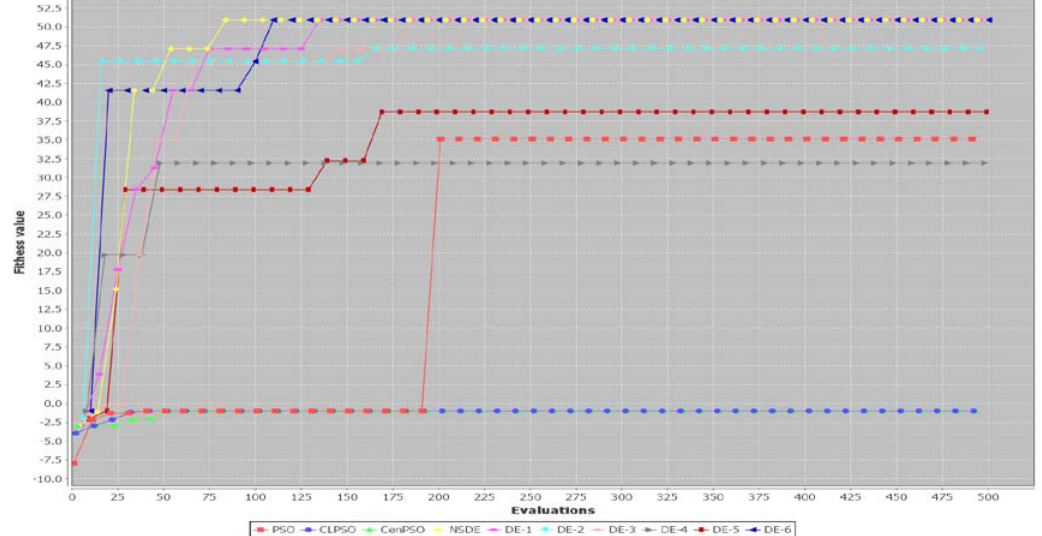
Figure A10. Convergence speed of a run of each algorithm for Case 10 with POP = 30.